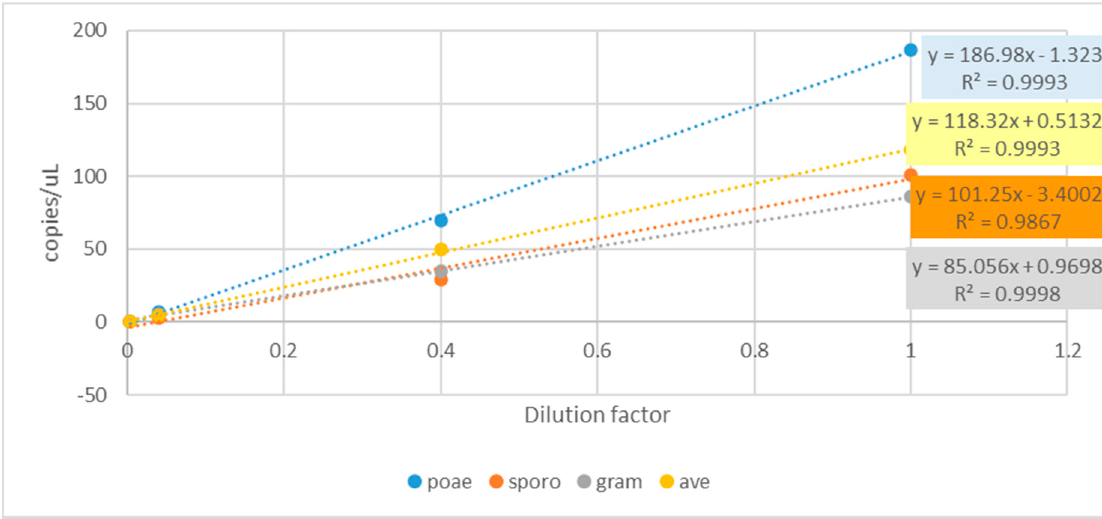
Figure 3. Linear regression among DNA dilution factors vs fungal copies numbers / µ L as determined by cdPCR amplification of F. poae (blue dots), F. sporotrichioides (red dots), F. graminearum (grey dots) and F. avenaceum (yellow dots).